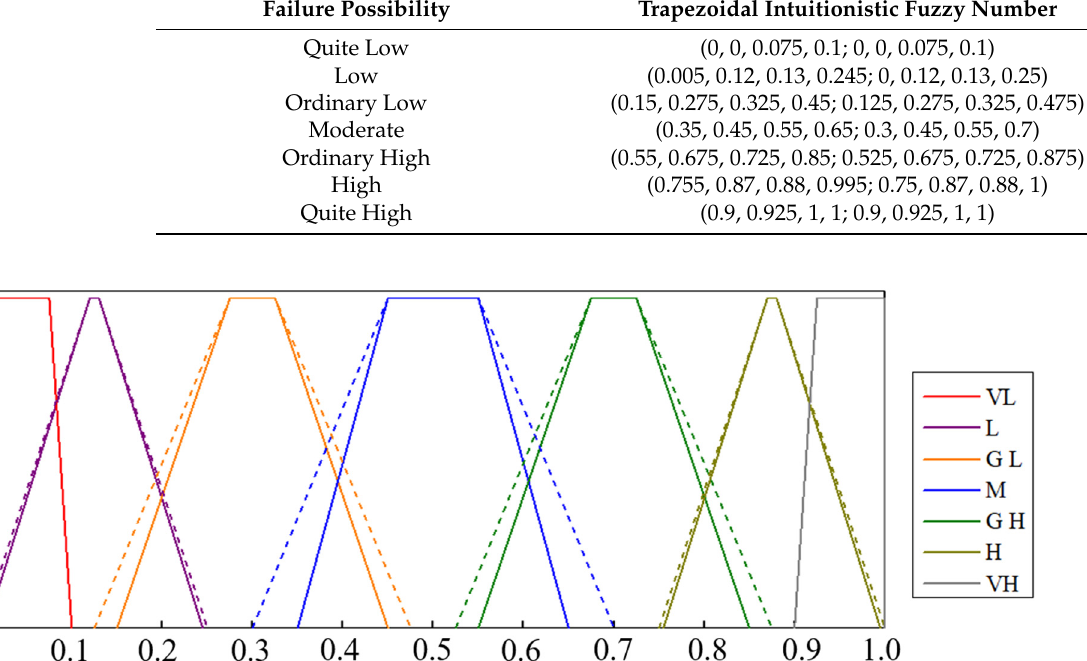
Figure 9. Membership and non-membership functions of probabilistic-language scales.